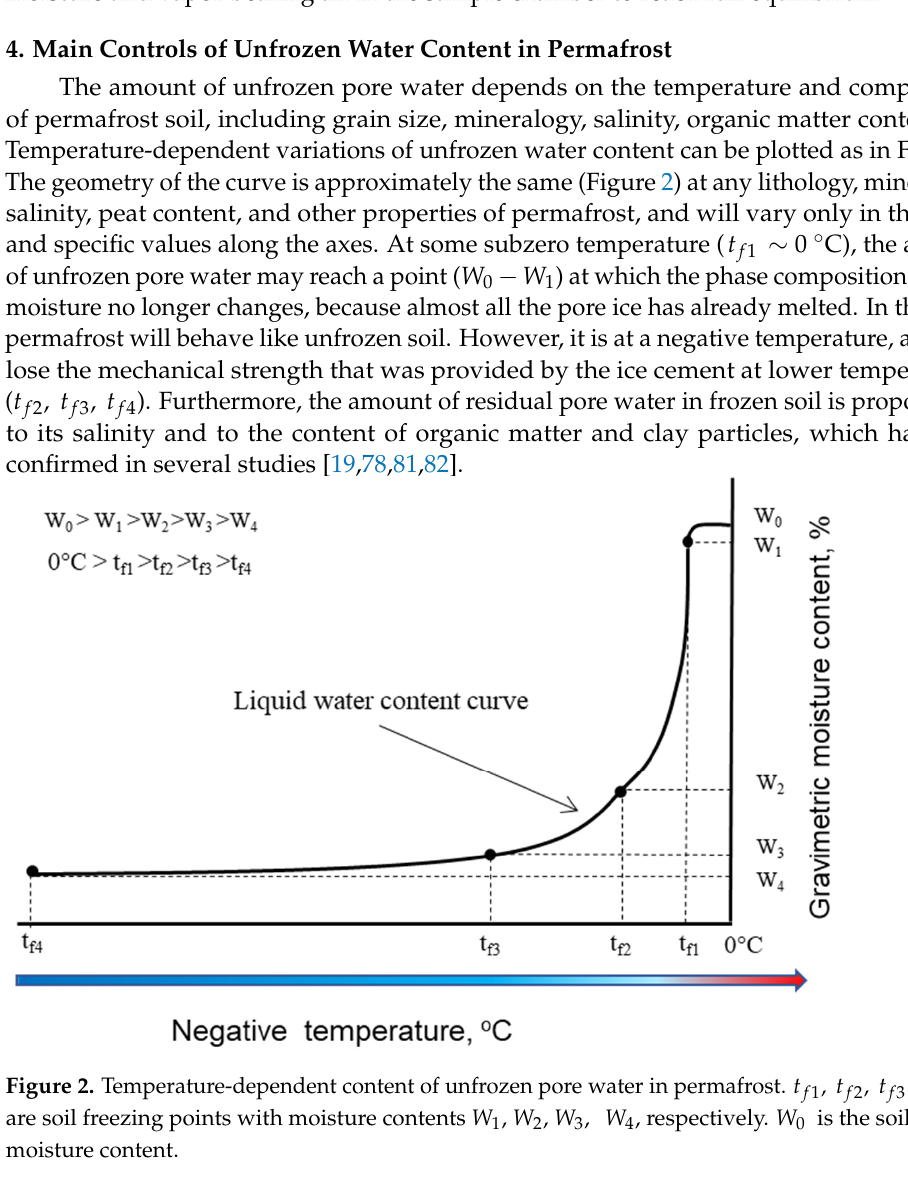
, (cid:1849) , respectively. (cid:1849) , (cid:1849) , (cid:1849) (cid:1849) (cid:2872) (cid:2868) is the soil 1 2 3